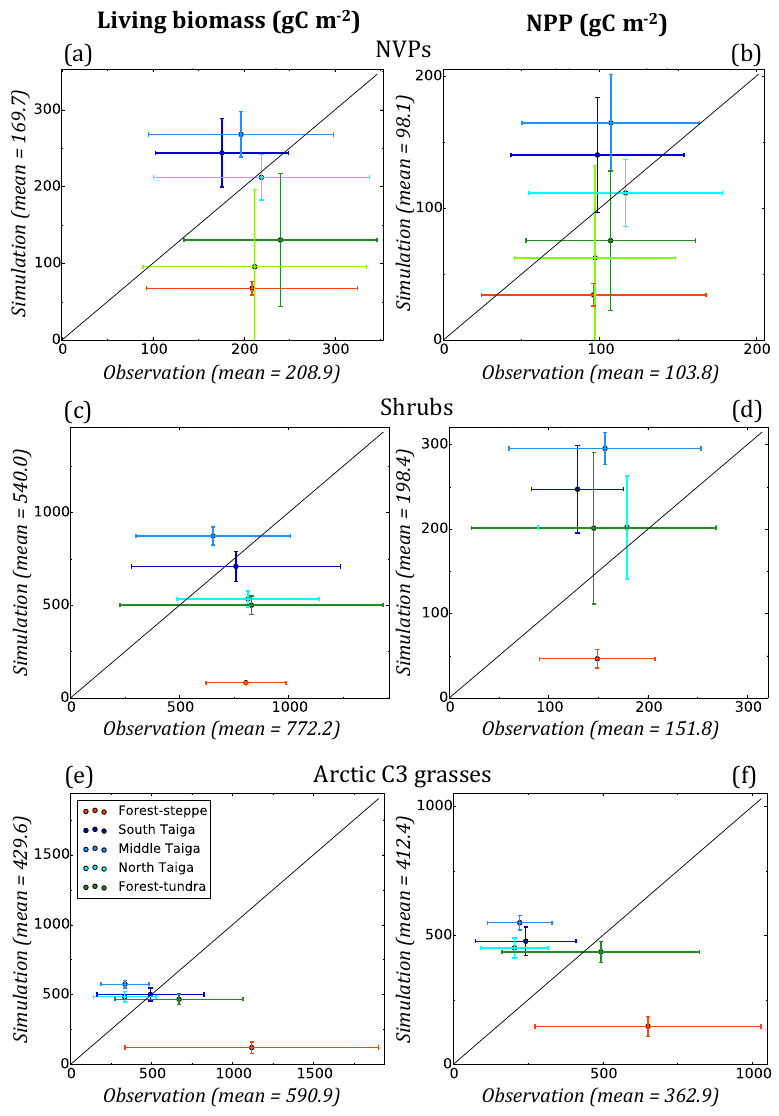
Figure 7. Model versus observed (from Peregon et al., 2008) values for the total living biomass (a, c, e) and the NPP (b, d, f) , for NVPs (a, b) , shrubs (c, d) and cold climate grasses (e, f) . The mean values for each subzone (with different sites and years) are displayed for the model and the observations. The colour indicates the associated bioclimatic zones: forest–steppe in the south, different taiga ecosystems (south, middle and north), forest–tundra and tundra in the far north. The error bars show the standard deviation due to the different sites and years considered by subzone, to which is added the standard deviation of measurements for